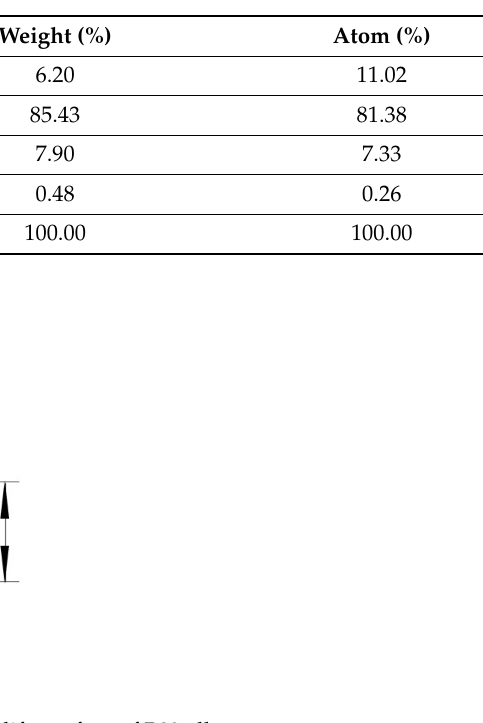
Figure 1. Diagram of Whorl pin used to modify surface of B89 alloy. Analysis of the microstructure of the studied materials along with analysis of the